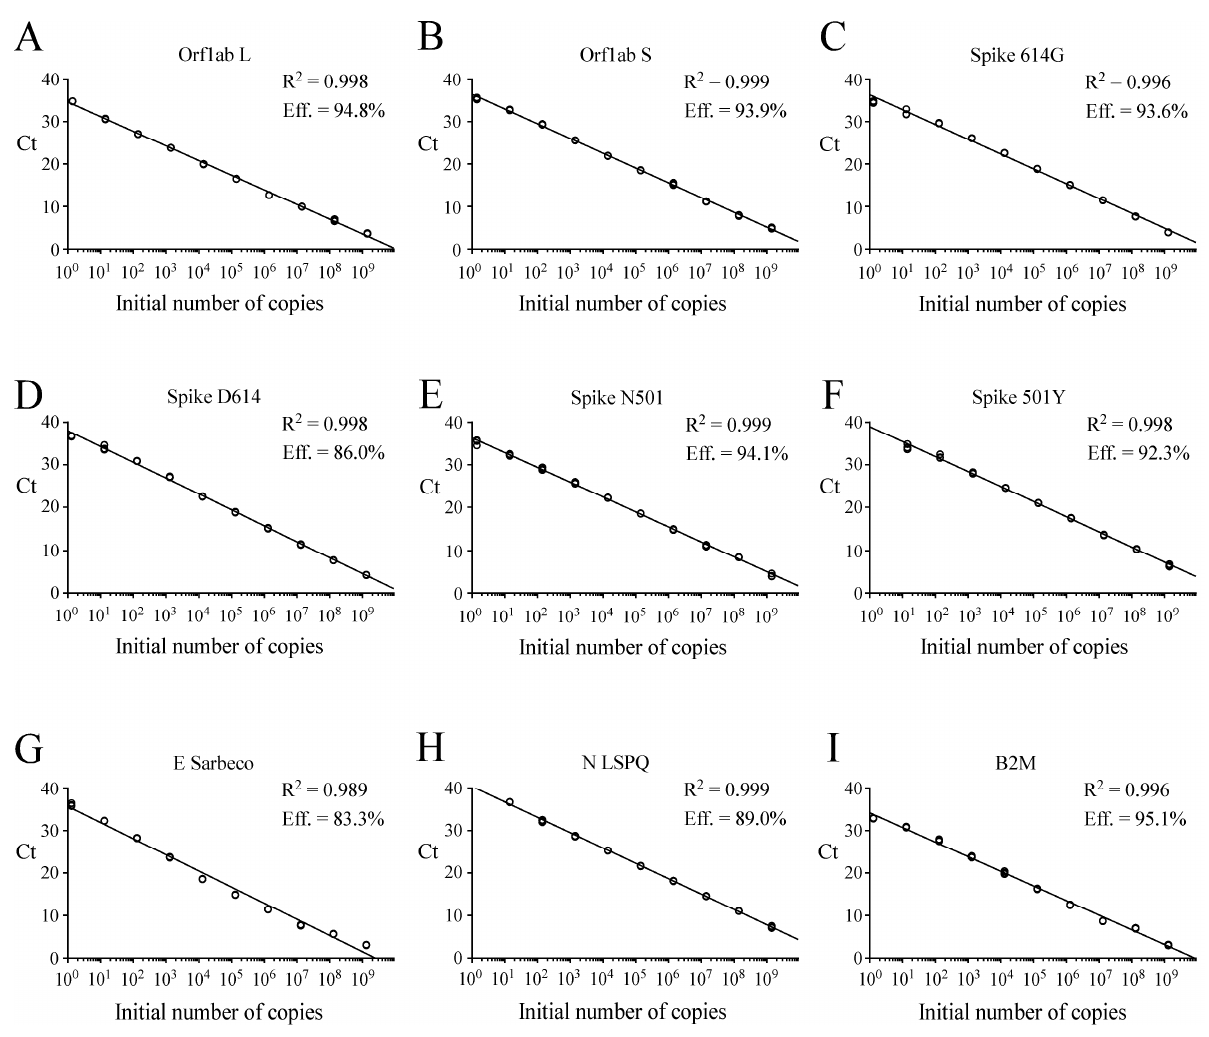
FIGURE 1: Standard curves to determine synthetic RNA copy number. (A–I) Tenfold serial dilutions ranging from 10 0 to 10 9 copies of Orf1ab L, Orf1ab S, Spike 614G, Spike D614, Spike N501, Spike 501Y, E Sarbeco (envelope), N LSPQ (nucleocapsid), and B2M synthetic RNA transcripts were analyzed by rRT-PCR assays . Each representative graph was generated by plotting the C t values (y-axis) and the log of initial number of copies of synthetic transcripts (x-axis). Calculated linear correlation coefficients (R 2 ) and percentage of amplification effi- ciencies are indicated for each primer-probe set. The graphs represent quantification of the results of three independent